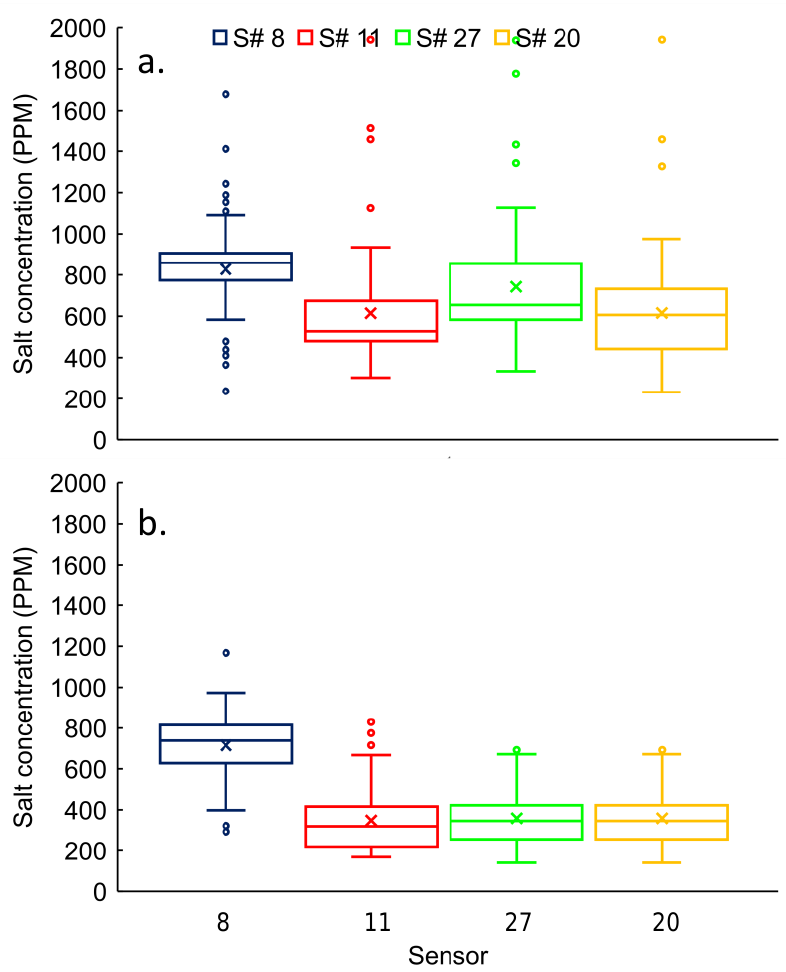
Figure 4. Salt concentrations distribution at roadside drains for S# 8, 11, 27, and 20 during ( a ) winter and ( b ) spring seasons.